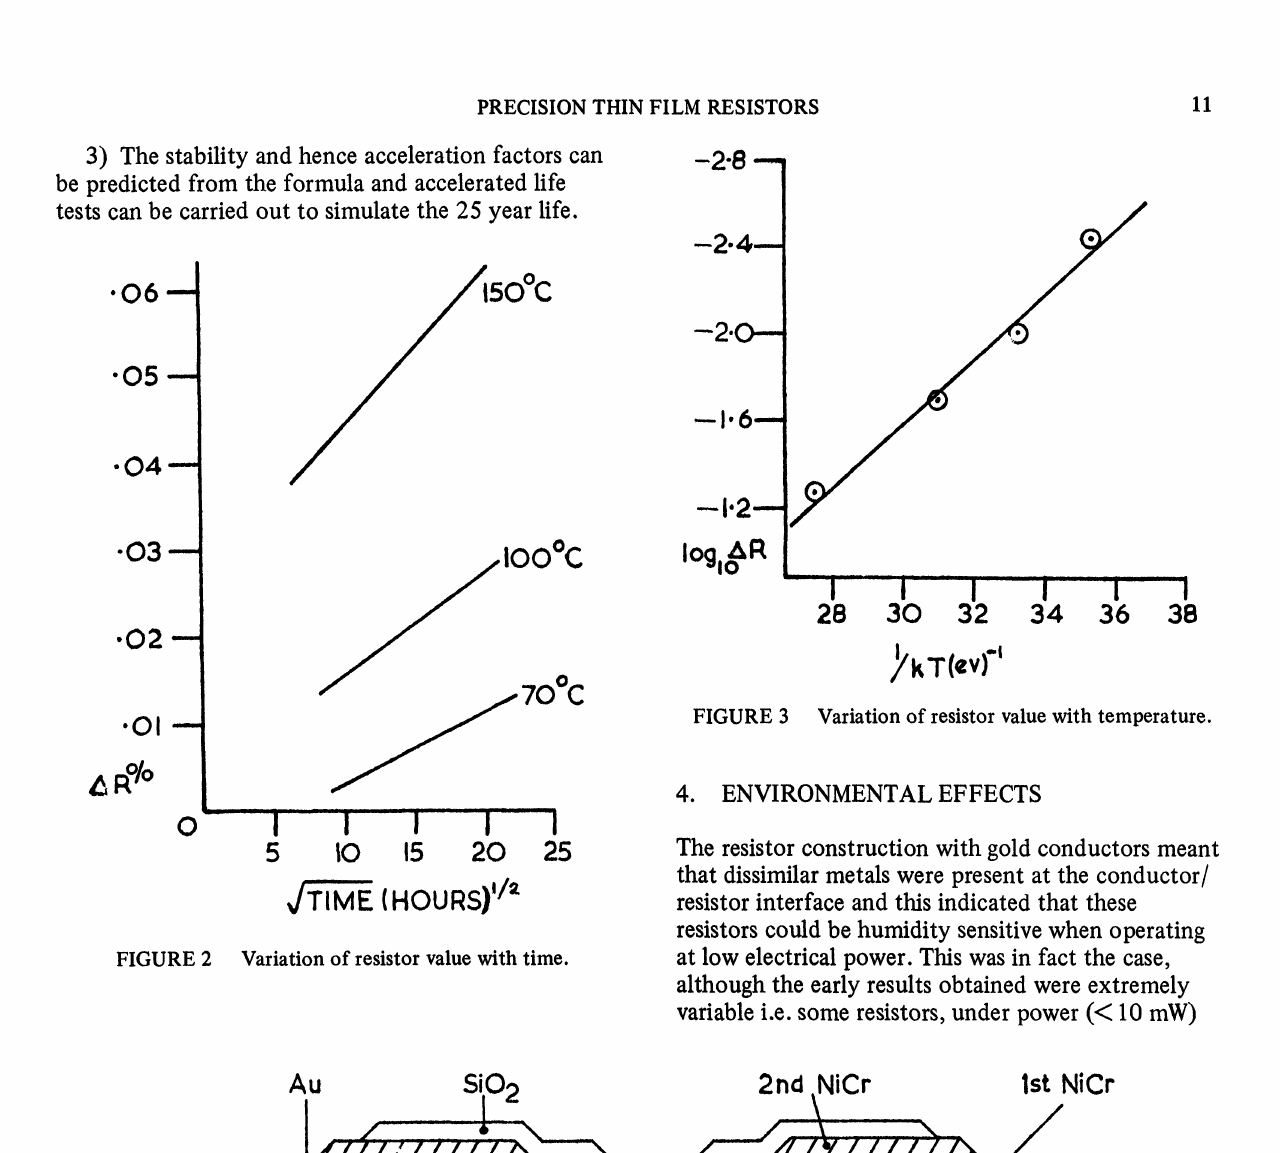
Variation of resistor value with time.